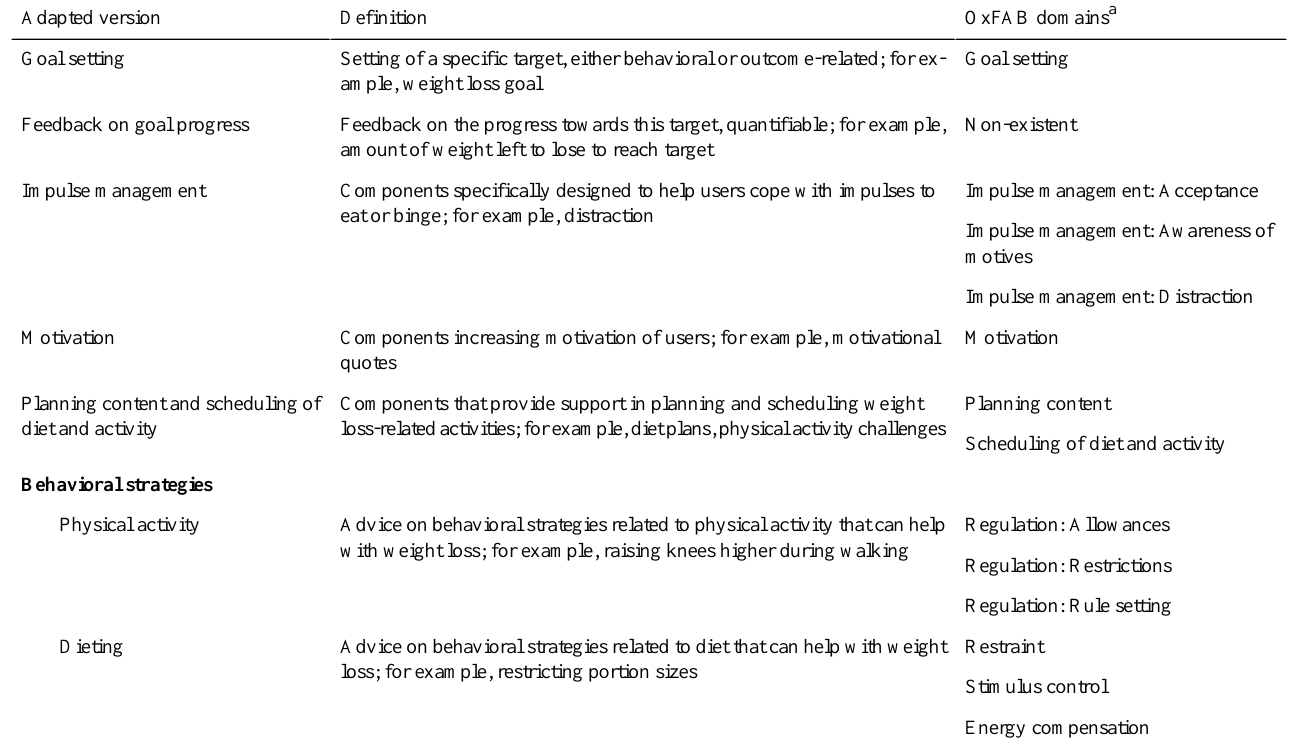
Table 1. Summary and definitions of components in the Oxford Food and Activity Behaviors (OxFAB) adaptation. The first column lists the adapted OxFAB components, the second column contains a definition for each adapted component and the third column contains the original OxFAB